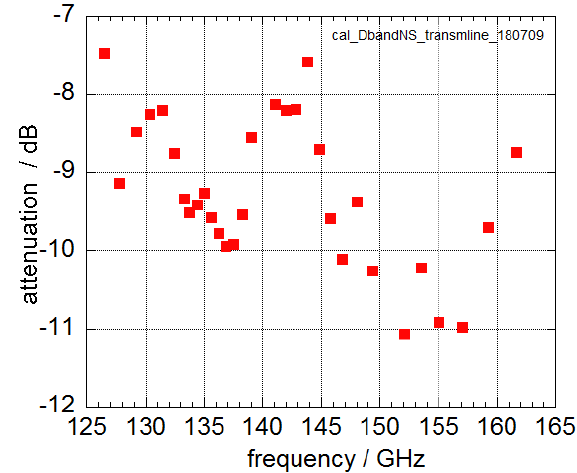
Fig. 2 : Insertion loss of the transmission line determined by differential measurement with a noise source and the radiometer cannels used for detection.